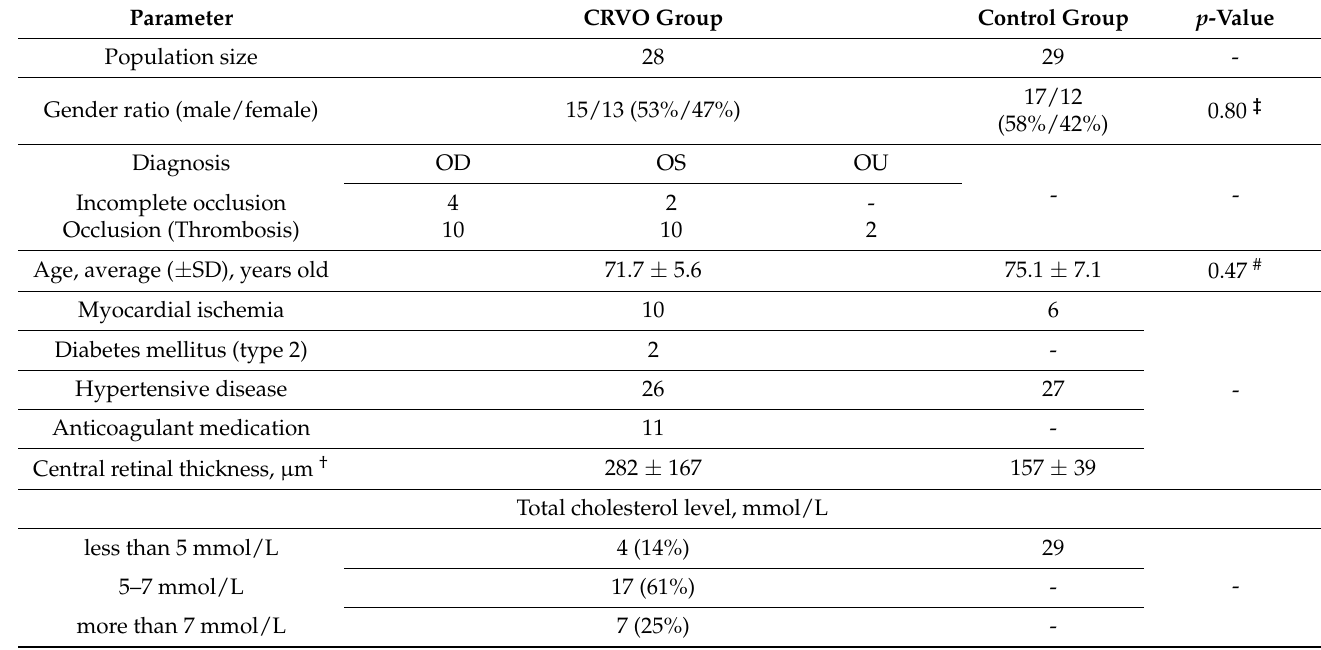
Table 2. Main clinical and anthropometric characteristics of subjects of CRVO group and relevant control group. Definitions in: OD—Ocular Dexter (right eye), OS—Oculus Sinister (left eye), OU— Oculus Uterque (both